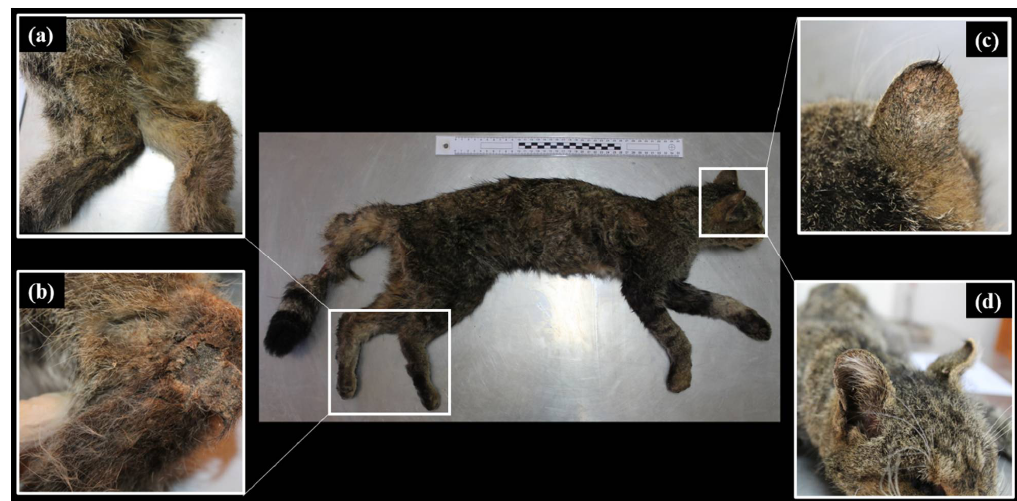
Figure 1. Physical aspect of the dead female European wildcat and most relevant macroscopic alterations reported during the necropsy. ( a ) Thickening of both tarsal joints. ( b ) Detail of hyperkeratosis of the left proximal tarsus. ( c ) Thickening and crusting in right pinnae. ( d ) Loss of hair density in the rostral plane.